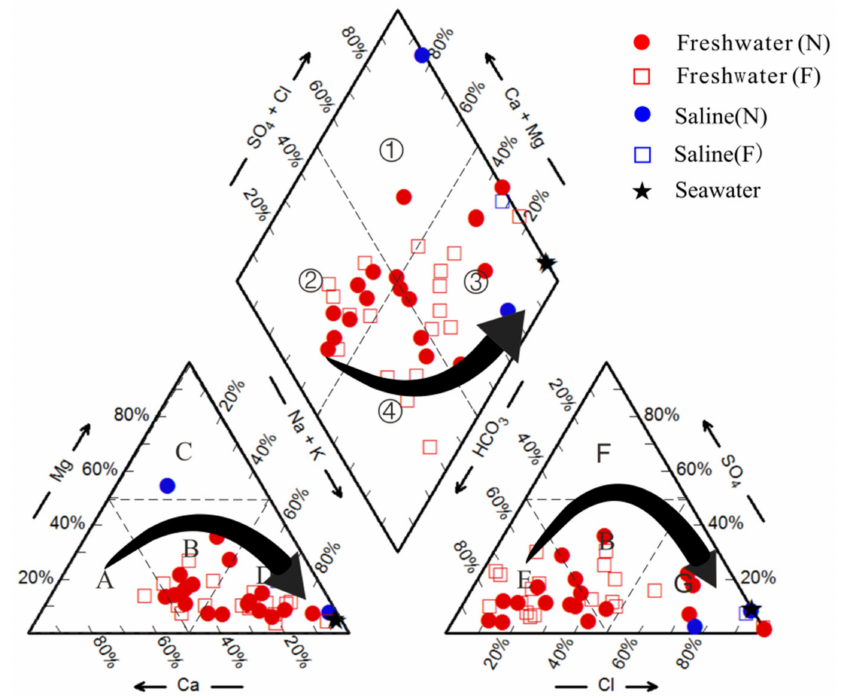
Figure 2. Piper diagram of water chemistry in the coastal zone of Guangdong province ( 1 (cid:13) Ca · Mg- SO 4 · Cl type; 2 (cid:13) Ca · Mg-HCO 3 type; 3 (cid:13) Na-SO 4 · Cl type; 4 (cid:13) Na-HCO 3 type; A. Calcium type; B. No dominant type; C. Magnesium type; D. Sodium type; E. Bicarbonate type; F. Sulfate type; G. Chloride type).